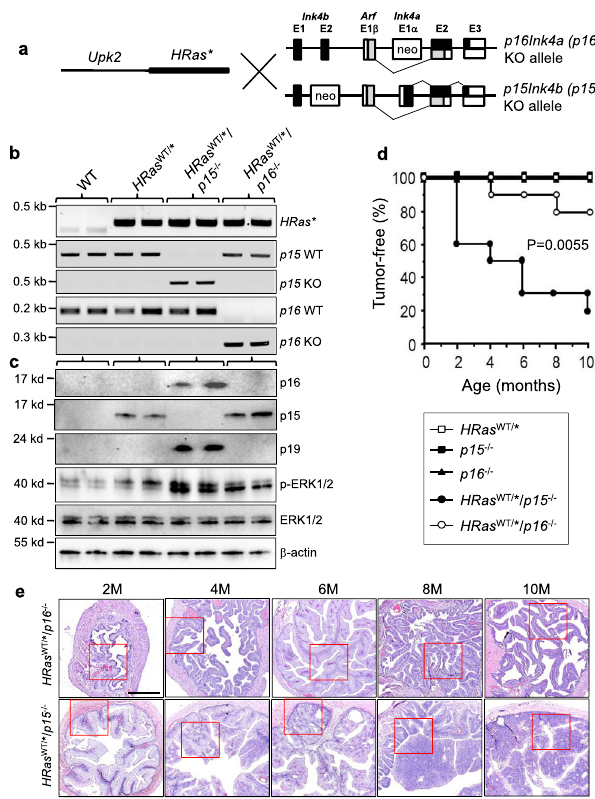
Fig. 2 Divergent effects of p15 loss or p16 loss in HRas -mediated urothelial tumorigenesis. a Mouse breeding scheme. Two sets of intercrosses were carried out (i) between Upk2 - HRas transgenic mice ( HRas*) and p16Ink4a ( p16 ) knockout ( p16 − / − ) in which exon 1 α of the gene was replaced by the neo gene, thus leaving an independent transcript of the gene, p19Arf , intact; and (ii) between HRas* transgenic mice and p15Ink4b ( p15 ) knockout ( p15 − / − ) mice. b Representative genotyping results by genomic PCR of major experimental groups and controls (1 mouse/lane; 2 mice/genotype). The genotyping was performed on every mouse with